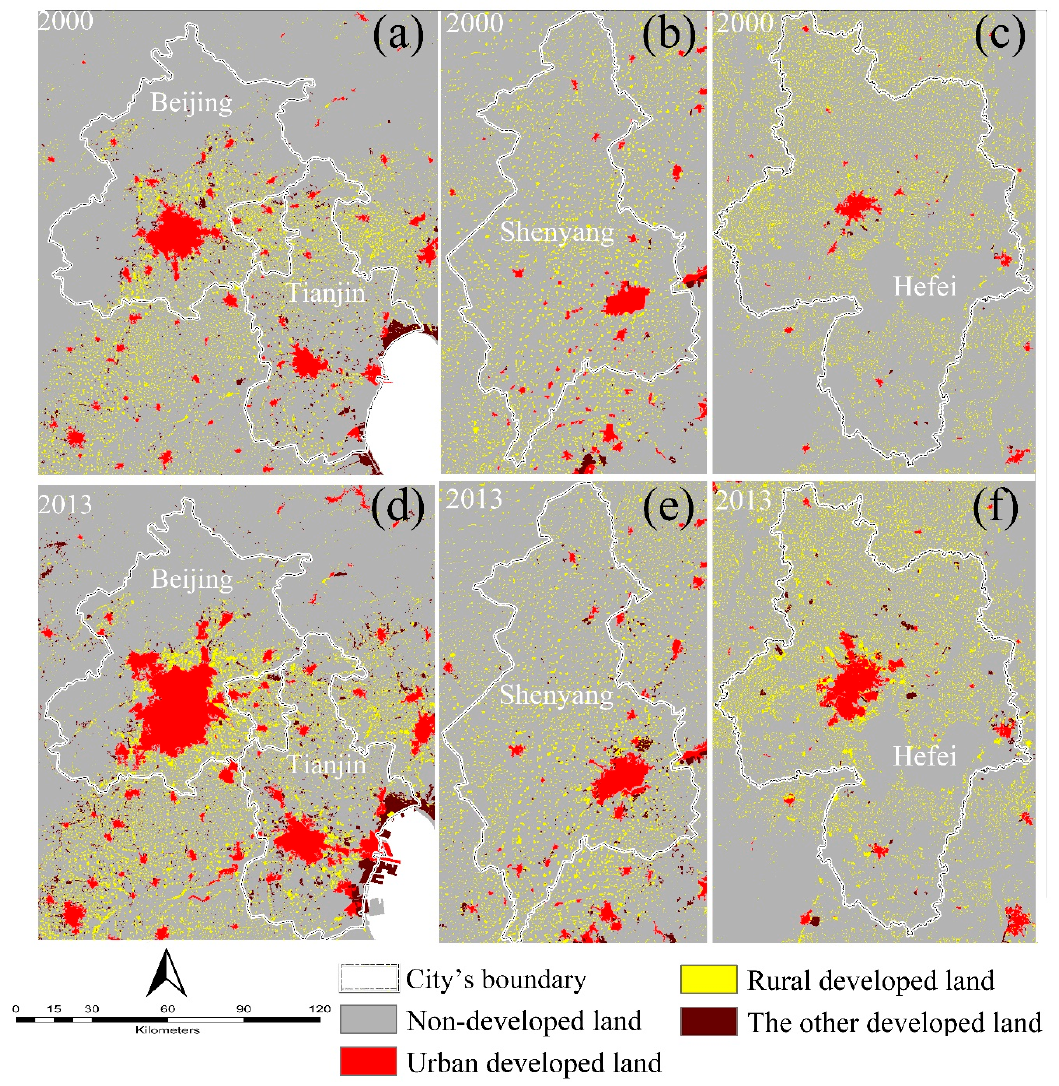
Figure 5. Dynamics of the three sub-categories of developed land in ( a , d ) Beijing, ( b , e ) Shenyang, and ( c , f ) Hefei in 2000 and 2013, respectively.